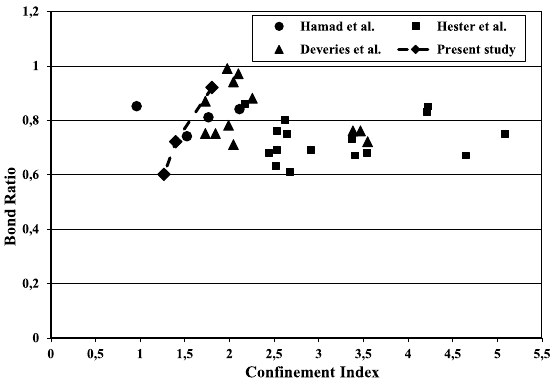
Figure 7. Load-Deflection curves for beams with 8 mm stirrups spaced @ 100.